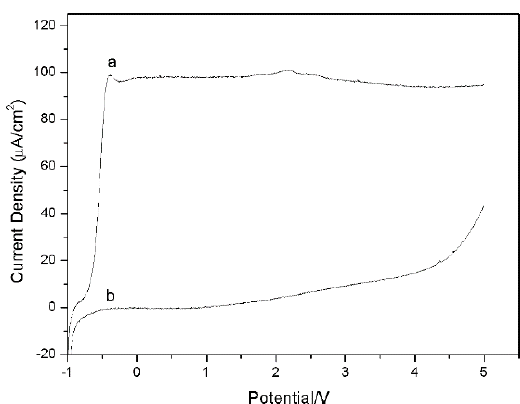
Figure 1. Ti6Al4V surface potentiodynamic curves of oxide growth (a) and reconstruction (b) in PBS solution at 5.0 V, before (a) and after (b) 30 days in artificial blood at room